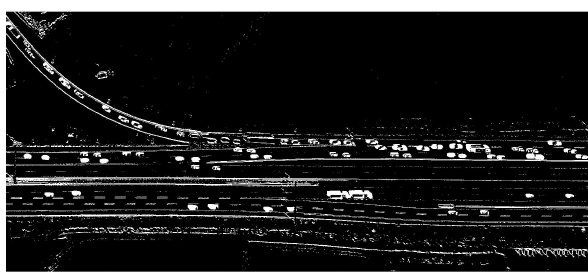
Figure 8: Difference image of image t 1 and t 2